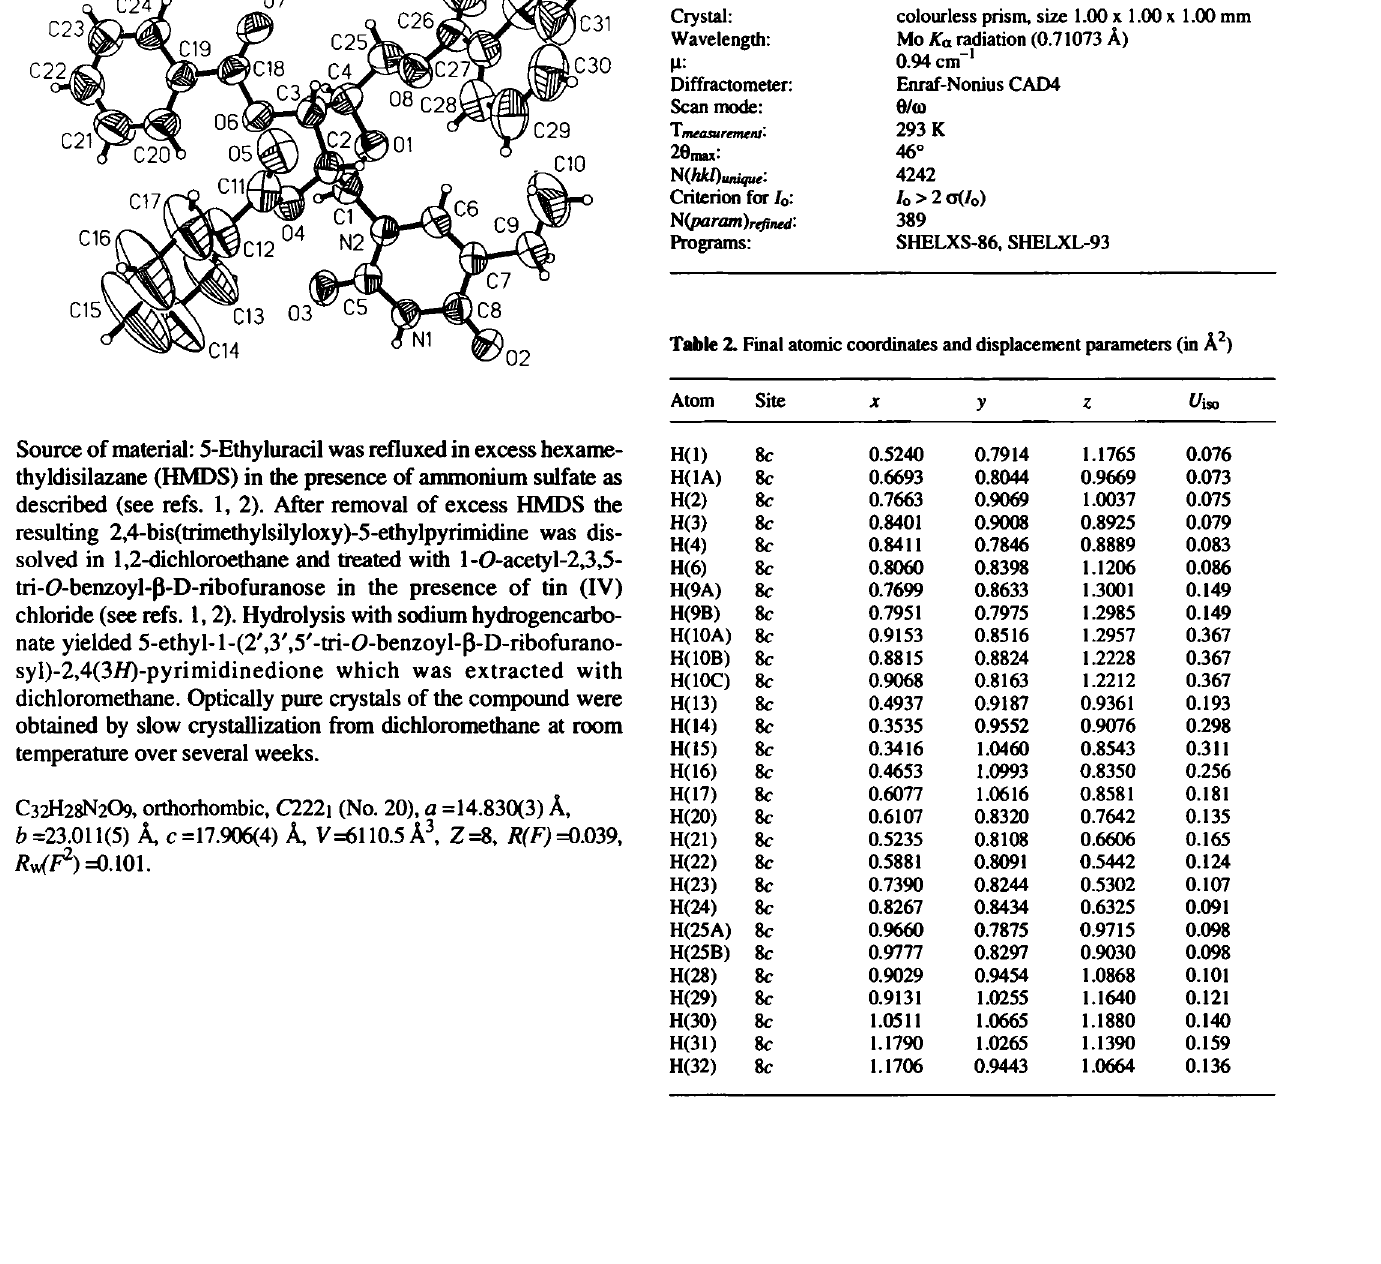
Table 1. Parameters used for the X-ray data